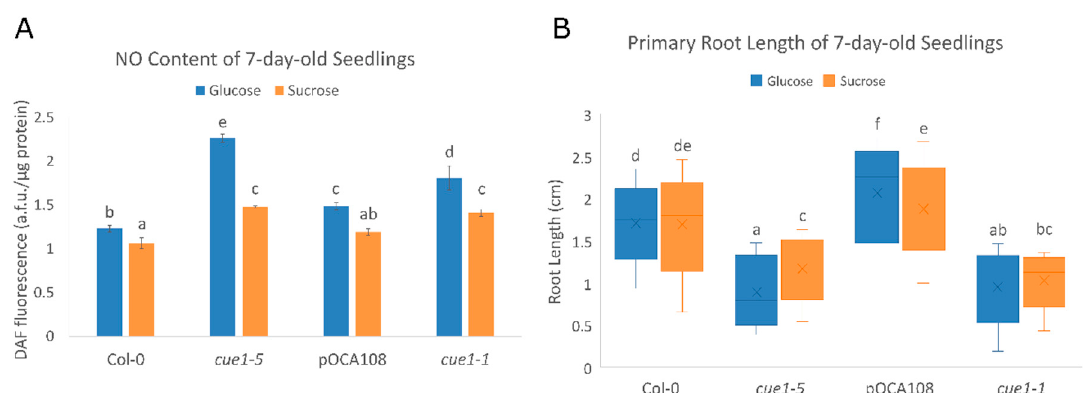
Figure 5. ( A ) The NO content of cue1 alleles depends on their developmental stage. DAF fluorescence intensity of extracts of 7-day-old seedlings grown on MS-Root medium supplemented with either 2%( w / v ) glucose or 0.75%( w / v ) sucrose. Values represent the mean ± CI ( n = 4). A two-way ANOVA with post-hoc Tukey’s HSD test showed a statistically significant interaction between genotype and carbon source ((F (3,24) = 33.99, p < 0.001, eta2[g] = 0.81). An analysis of simple main effects for each factor was performed with statistical significance after a Bonferroni correction (Table S2). ( B ) Primary root length is influenced by NO and sugar. Primary root length of 7-day-old seedlings grown on MS-Root supplemented with either 2%( w / v ) glucose or 0.75%( w / v ) sucrose ( n = 50). The diagram shows data between the lower (Q1) and upper (Q3) quartiles, the median and the mean (x) for each genotype. Common letters (a–f) indicate there are no significant statistical differences as determined by Welch’s one-way ANOVA with post-hoc Games–Howell test (F (7,571) = 203.57, p < 0.001).